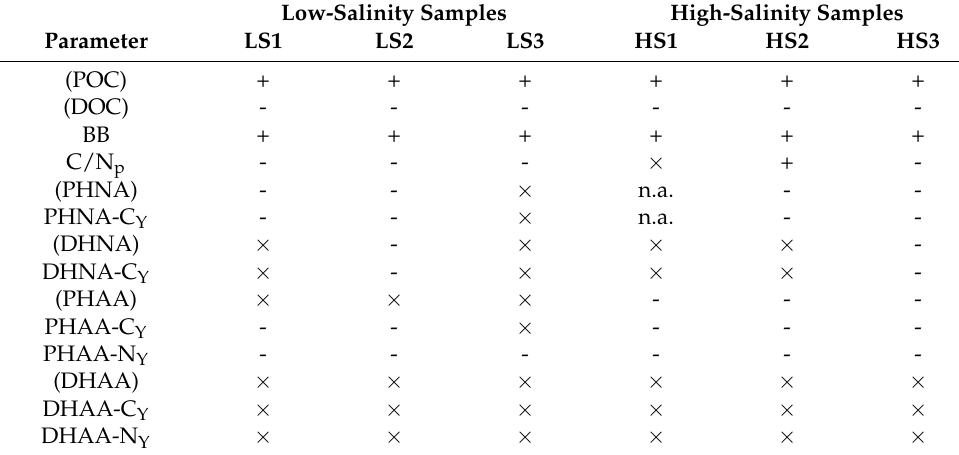
Table 2. Results from t -tests ( p < 0.05) between concentrations in the field and the treatment. A plus sign (+) denotes a significant increase in the treatment; a minus sign ( − ) denotes a significant decrease in the treatment; a cross sign ( × ) denotes no significant change between field and treatment